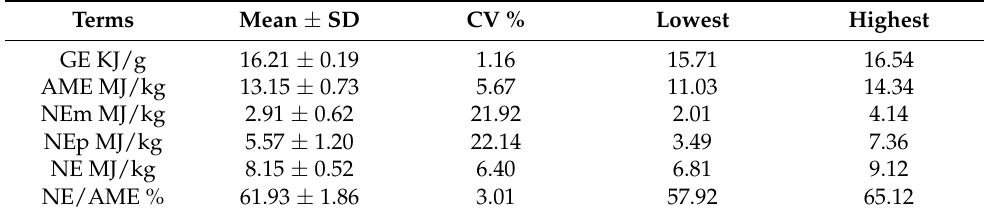
Table 3. Energy concentration and NE/AME of 40 wheat samples.